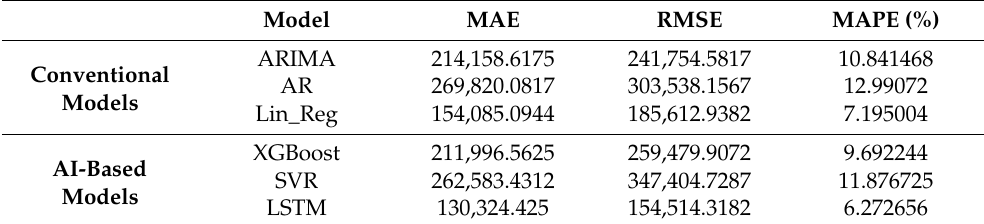
Table 2. Forecasting accuracy of the Marrakech-Safi region for all the models. Model MAE RMSE MAPE (%) Conventional Models